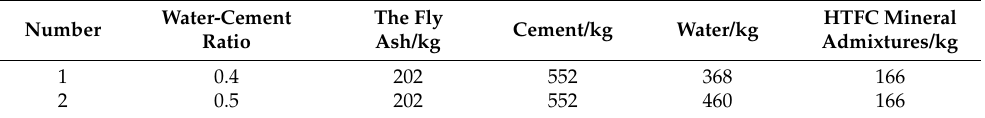
Table 3. Foamed concrete base mix